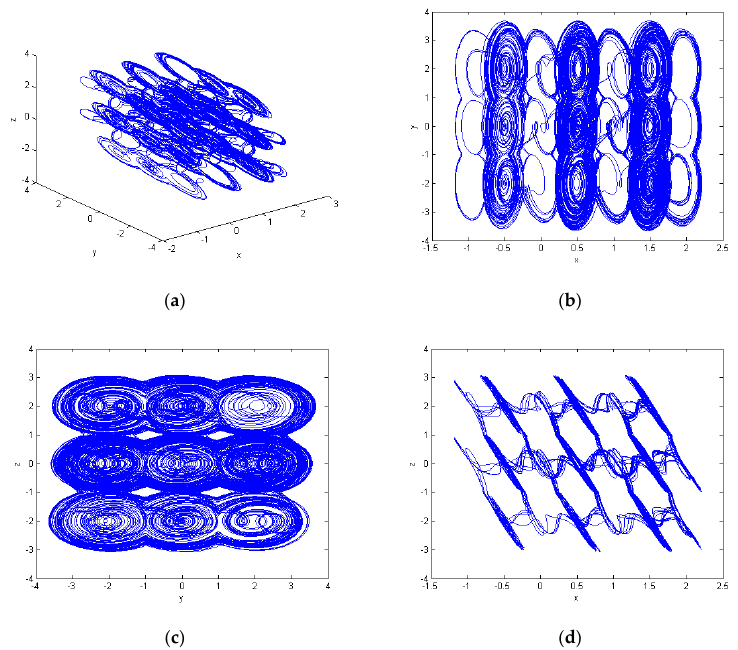
Figure 2. (Color online) chaotic attractors with 3 × 3 × 3-scroll of system (2) with: n 1 = 1, n 2 = 2, f 1 ( y ) = f 11 ( y ) , f 2 ( z ) = f 21 ( z ) , N 11 = 0, N 21 = 0, and ( x 0 , y 0 , z 0 ) = ( 0.1,0,0 ) : ( a ) x–y–z plane; ( b ) projection on the x–y plane; ( c ) projection on the y–z plane; and ( d ) projection on the x–z plane. Type 2: n 1 = 1, n 2 = 2, f 1 ( y ) = f 12 ( y ) , f 2 ( z ) = f 21 ( z ) , N 12 = 1, and N 21 = 0, the chaotic attractors with 3 × 4 × 3-scroll are shown in Figure 3.